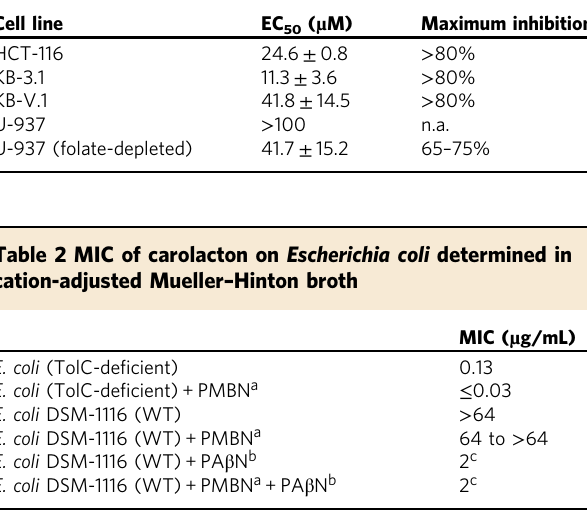
Table 1 EC 50 values of carolacton on human cancer cell lines